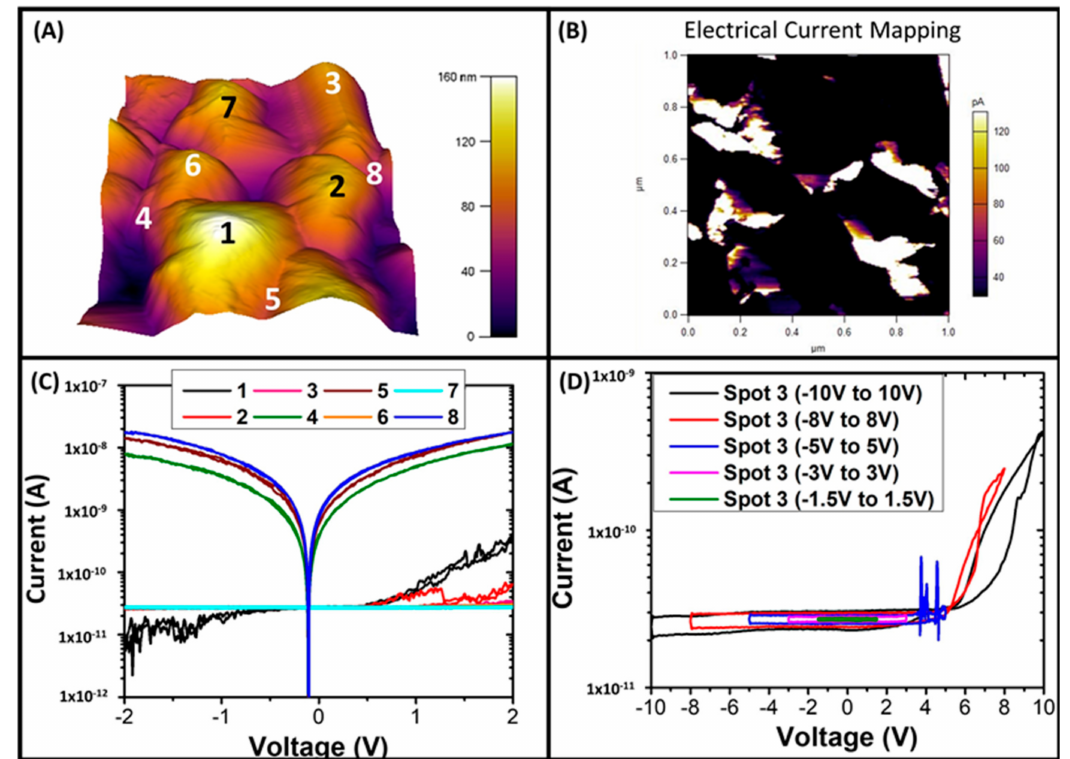
Figure 8. Conductive atomic force microscopy (CAFM) from MCD film grown for 4 h with 200 sccm H 2 sccm CH 4 gas flow (see Table 1). ( A ) AFM topography mapping from a 1 × 1 µ m area. ( B ) Electrical current mapping. ( C ) Curves I-V from the spots indicated in ( A ). ( D ) Curves I-V for voltages in the range − 10 V to +10 V, applied to spot 3 as shown in ( A